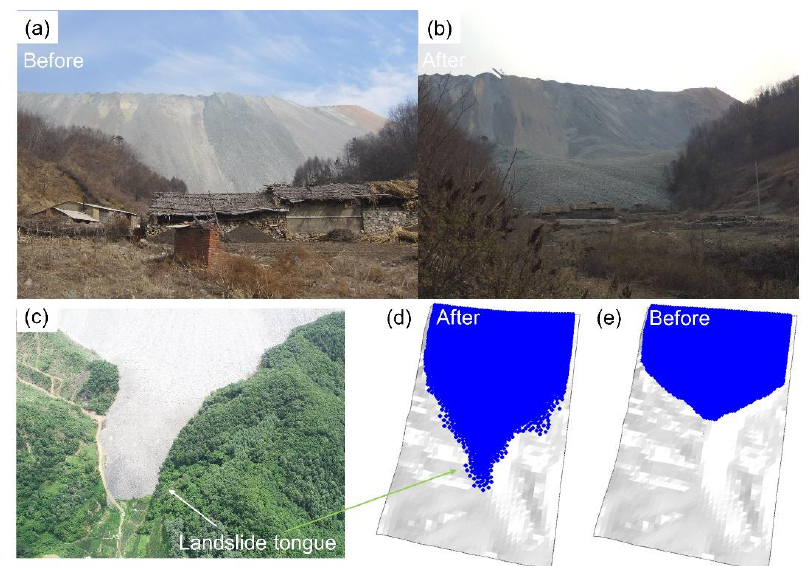
Figure 9. Illustration for the dump slope, ( a ) before landslides; ( b ) after landslides; ( c ) landslide tongue; ( d ) landslides by the SPH simulation; ( e ) the geometry model of landslides. To observe the process of landslides simulated by SPH, the movement ranges of sliding bodies at different time steps t = 0 s, 10 s, 20 s, 30 s, 40 s, and 100 s are presented in Figure 10, respectively. It is found that at the simulating time t = 30 s, the profile of landslides tends to be almost unchanged. Observing the motion of the slope from t = 0 s to t = 30 s, it is noted that sliding bodies mostly move along the gully, and the movement direction of the landslides is affected by the topography. At the bottom of the dump slope, the movement of the landslide mass is limited by the slope on both sides. The landslide masses partially accumulate at the foot of the slope and partially converge into the middle valley, forming a tongue-like landslide.